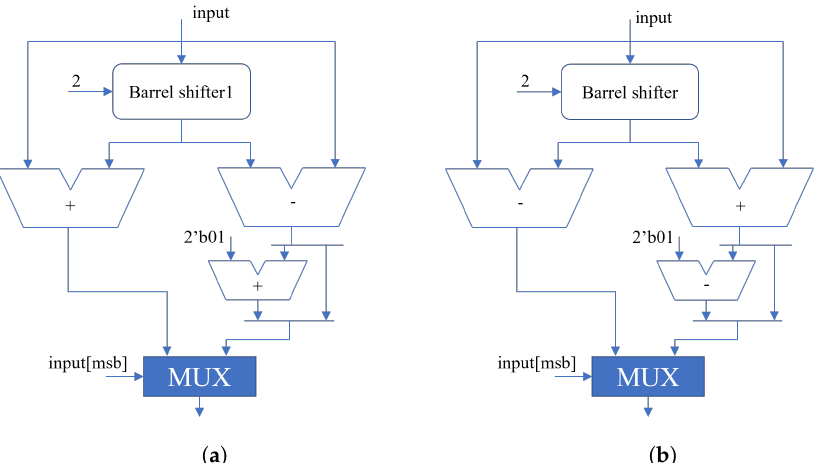
Figure 4. Piecewise linear function modules of Pwl-Mit approximate multiplier. ( a ) Module of linear function p ( x ) . ( b ) Module of linear function q ( x ) .